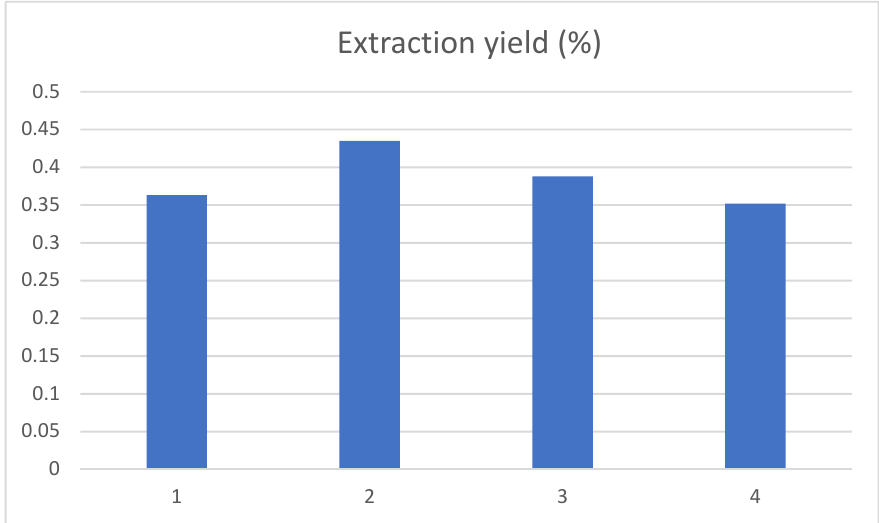
Figure 5. Influence of pH value on the extraction yield of chlorogenic acid, and the 1, 2, 3, and 4 represent the pH value of 3, 4, 5 and 6, respectively.